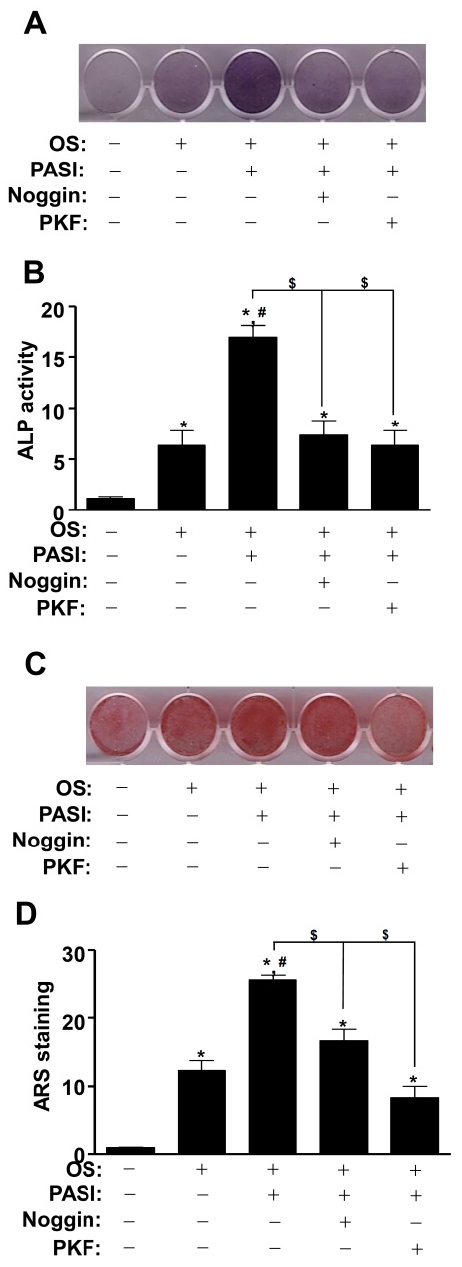
Figure 7. Blockage of BMP2 and Wnt3a/ β -catenin signaling attenuated PASI-mediated osteoblast differentiation. ( A , B ) The staining of ALP was visualized using a scanner ( A ), and the activity of ALP was analyzed using a spectrophotometer and exhibited as a bar graph ( B ). ( C , D ) The staining of ARS was visualized using a scanner ( C ), and the quantification was presented as a bar graph ( D ) (bottom). Data are expressed as the mean ± S.E.M. of experiments. * p < 0.05, # p < 0.05, and $ p < 0.05 indicate a statistically significant difference compared to the control, OS, and OS + PASI,